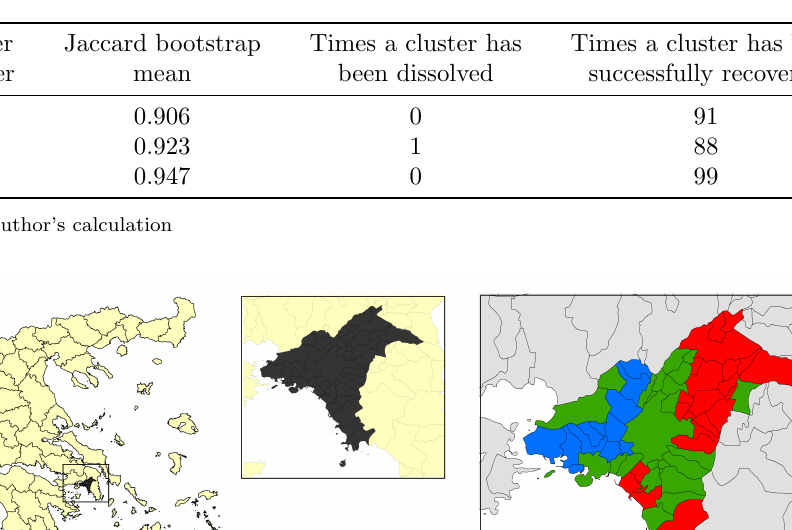
Table 3: Results for bootstrap method of resampling